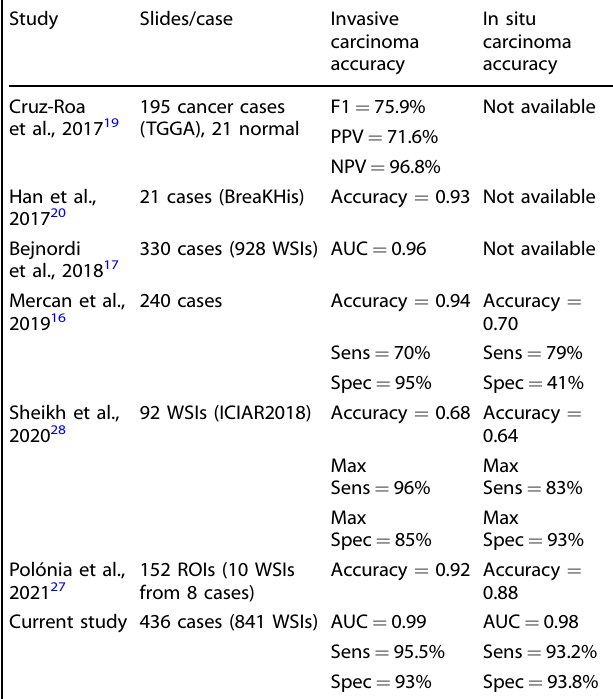
Table 3. Performance of algorithms in the detection of invasive and in situ breast